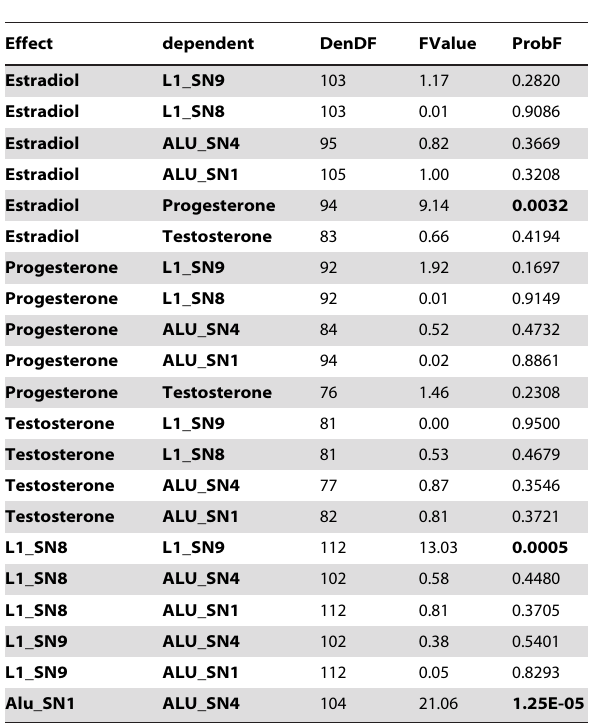
Table 2. The influence of different hormone levels as fixed and women and month of cycle as random effects on different methylation measurements calculated by a mixed linear model is shown in this